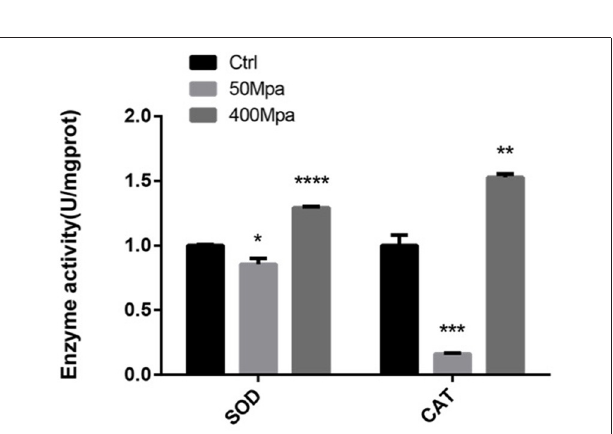
FIGURE 4 | Enzyme activity of superoxide dismutase (SOD) and catalase (CAT) of E. sakazakii with different pressures. Asterisks indicate difference between control and different HHPs at * P < 0.05, ** P < 0.01, *** P < 0.001, and **** P <